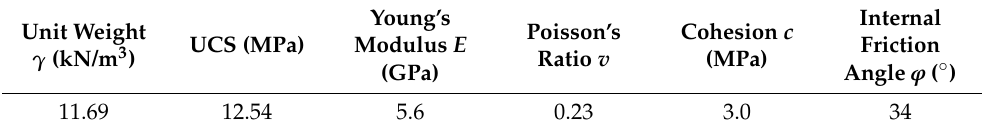
Figure 1. ( a ) Sketches of specimen’s geometry and joint geometry; ( b ) photograph of a sample ( β = 60 ◦ ). Table 1. Physical and mechanical properties of the modeled material.